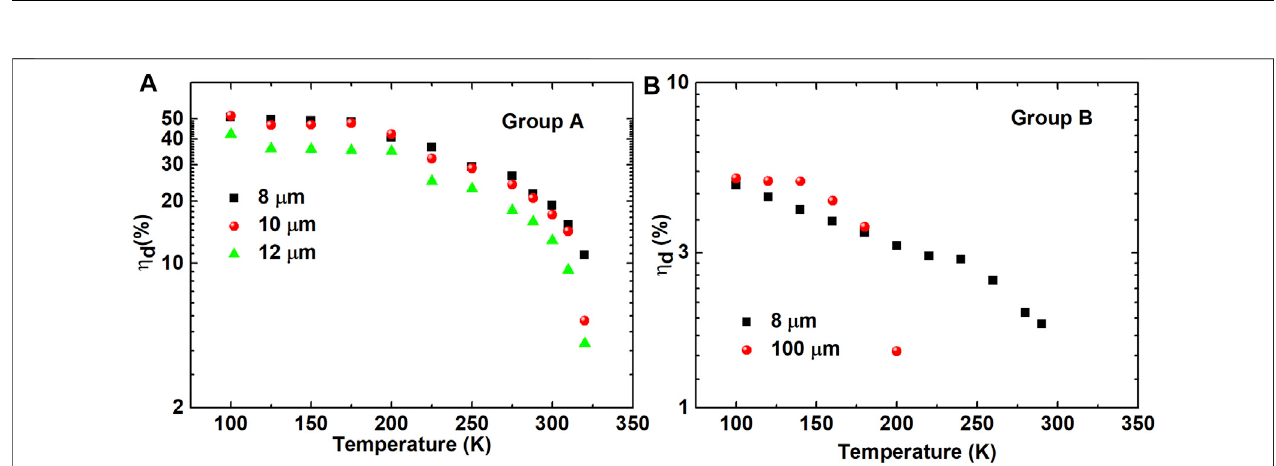
FIGURE 5 | External differential quantum ef fi ciencies η d at different temperatures for (A) group A and (B) group B lasers.